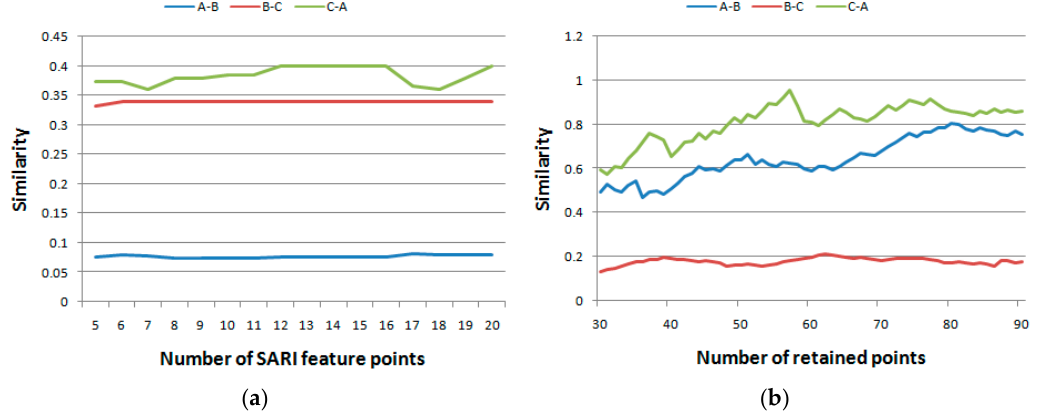
Figure 9. The impacts of parameters on the ROSIS dataset. ( a ) Impact on the number of SRAI feature points and ( b ) on the number of retained points.